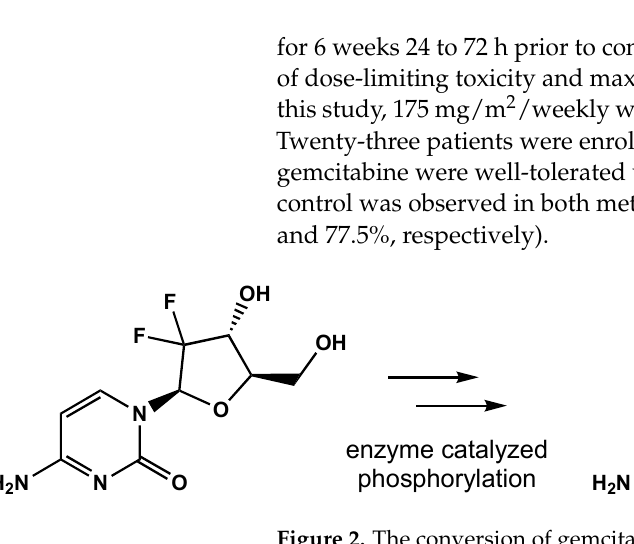
Figure 2. The conversion of gemcitabine to gemcitabine-5 (cid:48) -triphosphate before being incorporated into DNA and RNA, eventually leading to strand